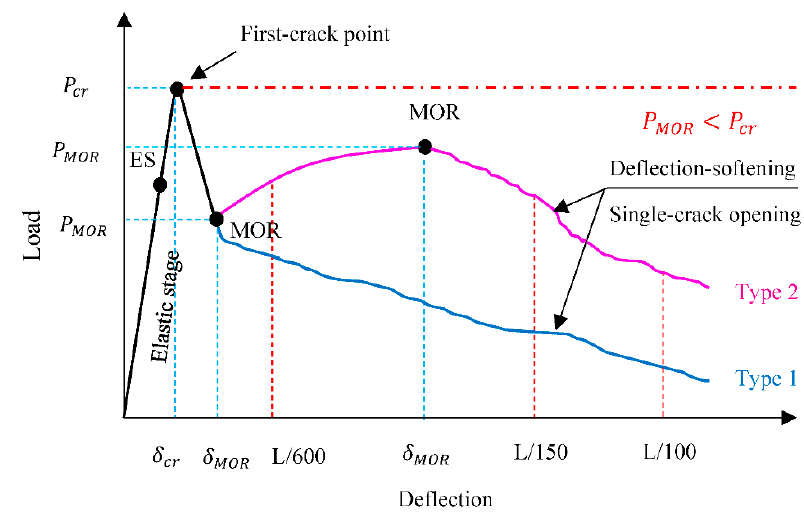
Figure 3. Typical behavior of deflection-softening materials under bending test.